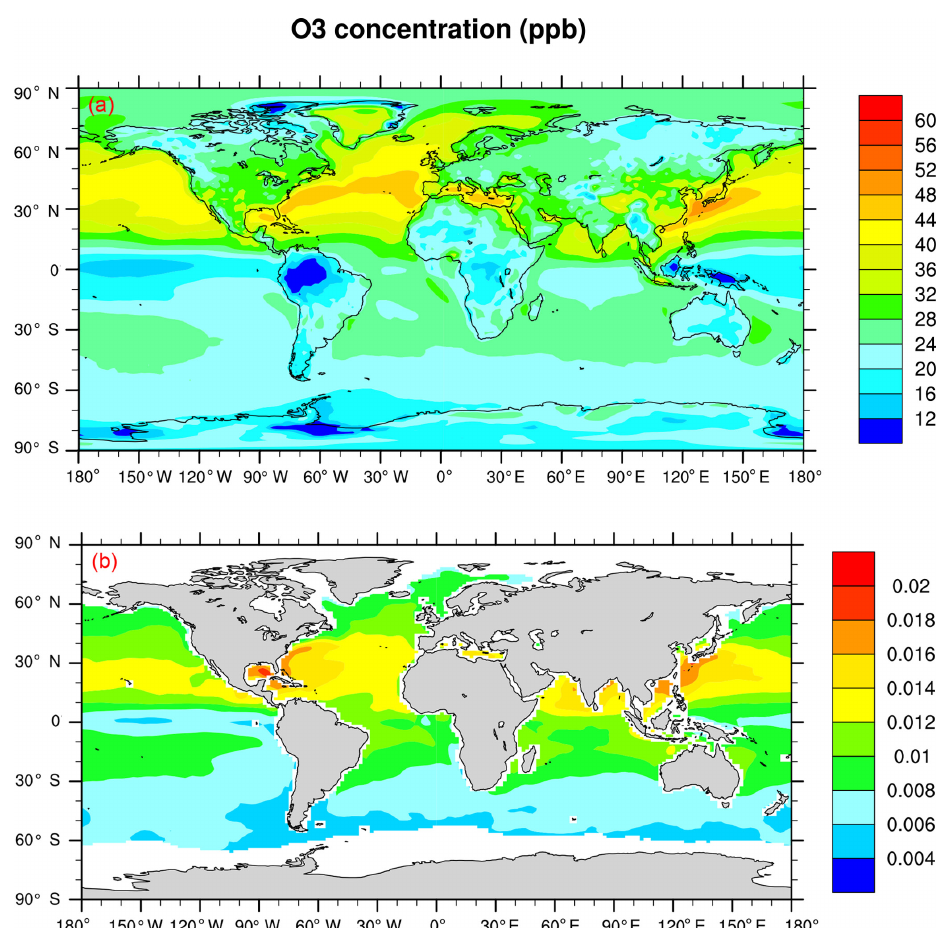
Figure 10. (a) Mean surface ozone mixing ratio (ppbv) and (b) mean oceanic ozone dry deposition flux (µgm − 2 s − 1 ) for 2005 obtained from the MACC